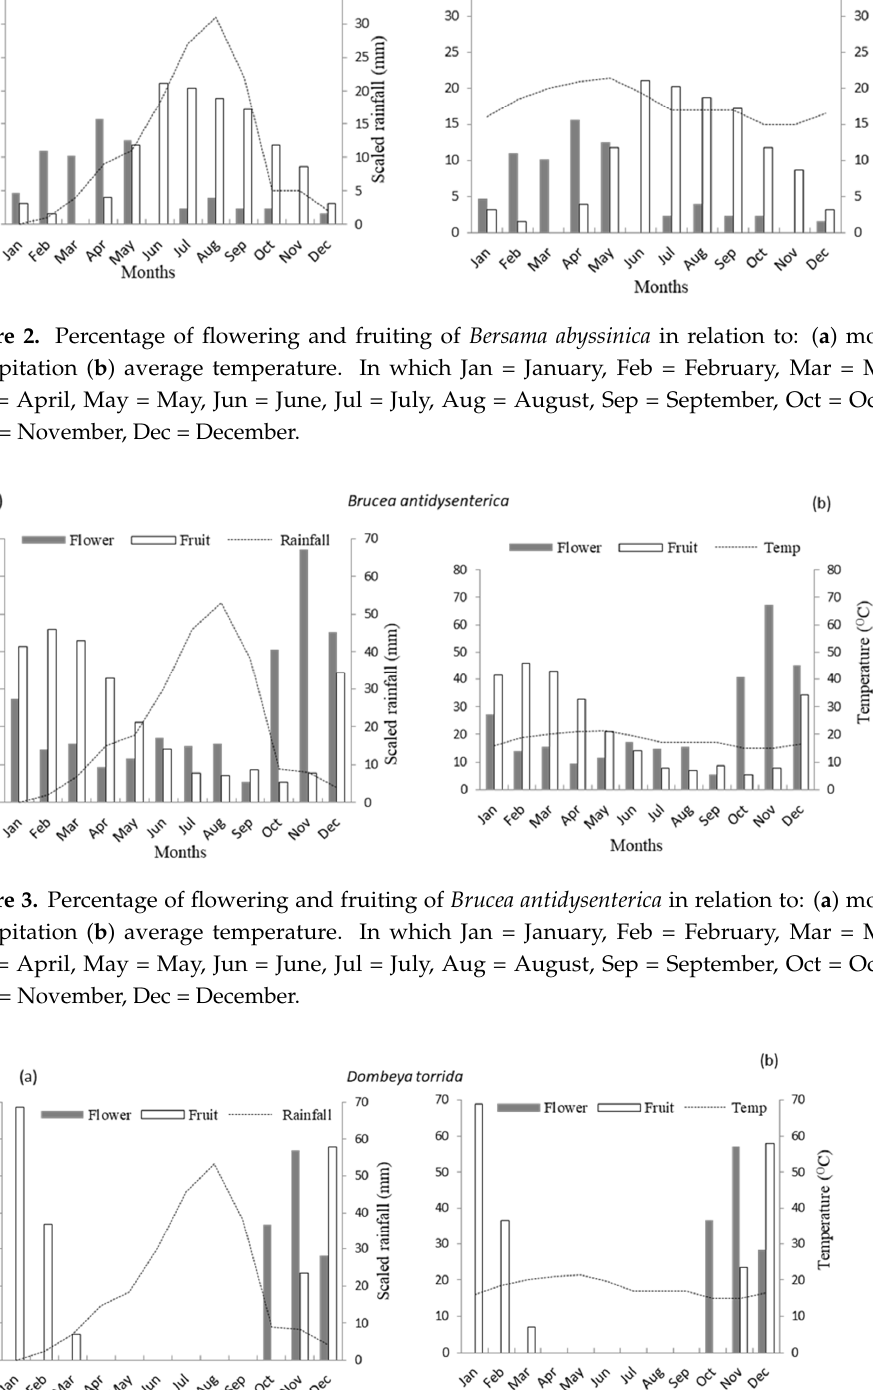
Figure 4. Percentage of flowering and fruiting of Dombeya torrida in relation to: ( a ) monthly precip ‐ itation and ( b ) average temperature. In which Jan = January, Feb = February, Mar = March, Apr = April, May = May, Jun = June, Jul = July, Aug = August, Sep = September, Oct = October, Nov = November, Dec =